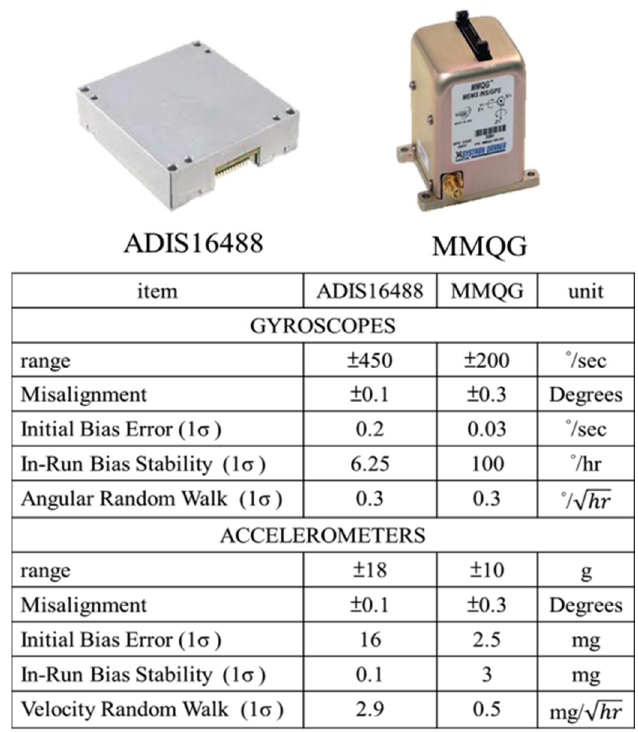
Figure 9. The IMUs for DG